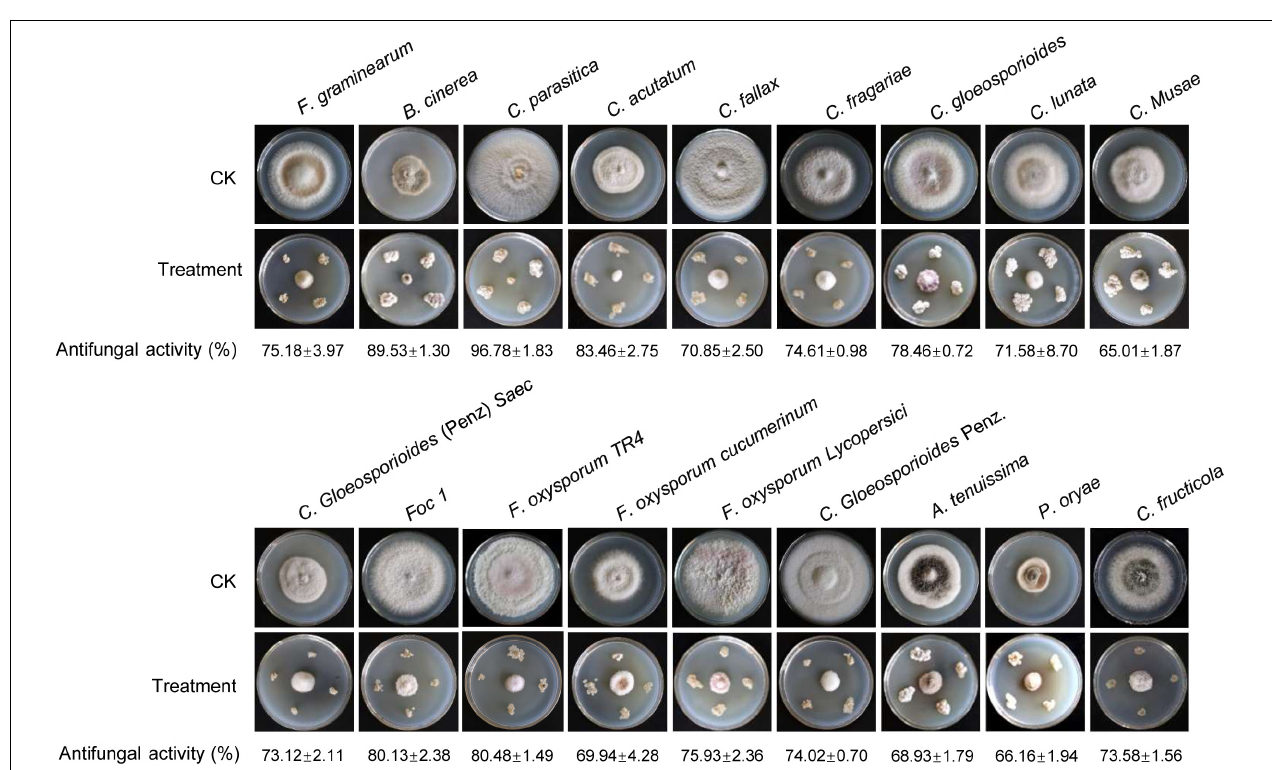
FIGURE 3 | Determination of a broad-spectrum antifungal activity of Streptomyces BITDG-11 against the 18 selected phytopathogenic fungi. Different data below the picture indicate antifungal activity of Streptomyces BITDG-11 against different phytopathogenic fungi.